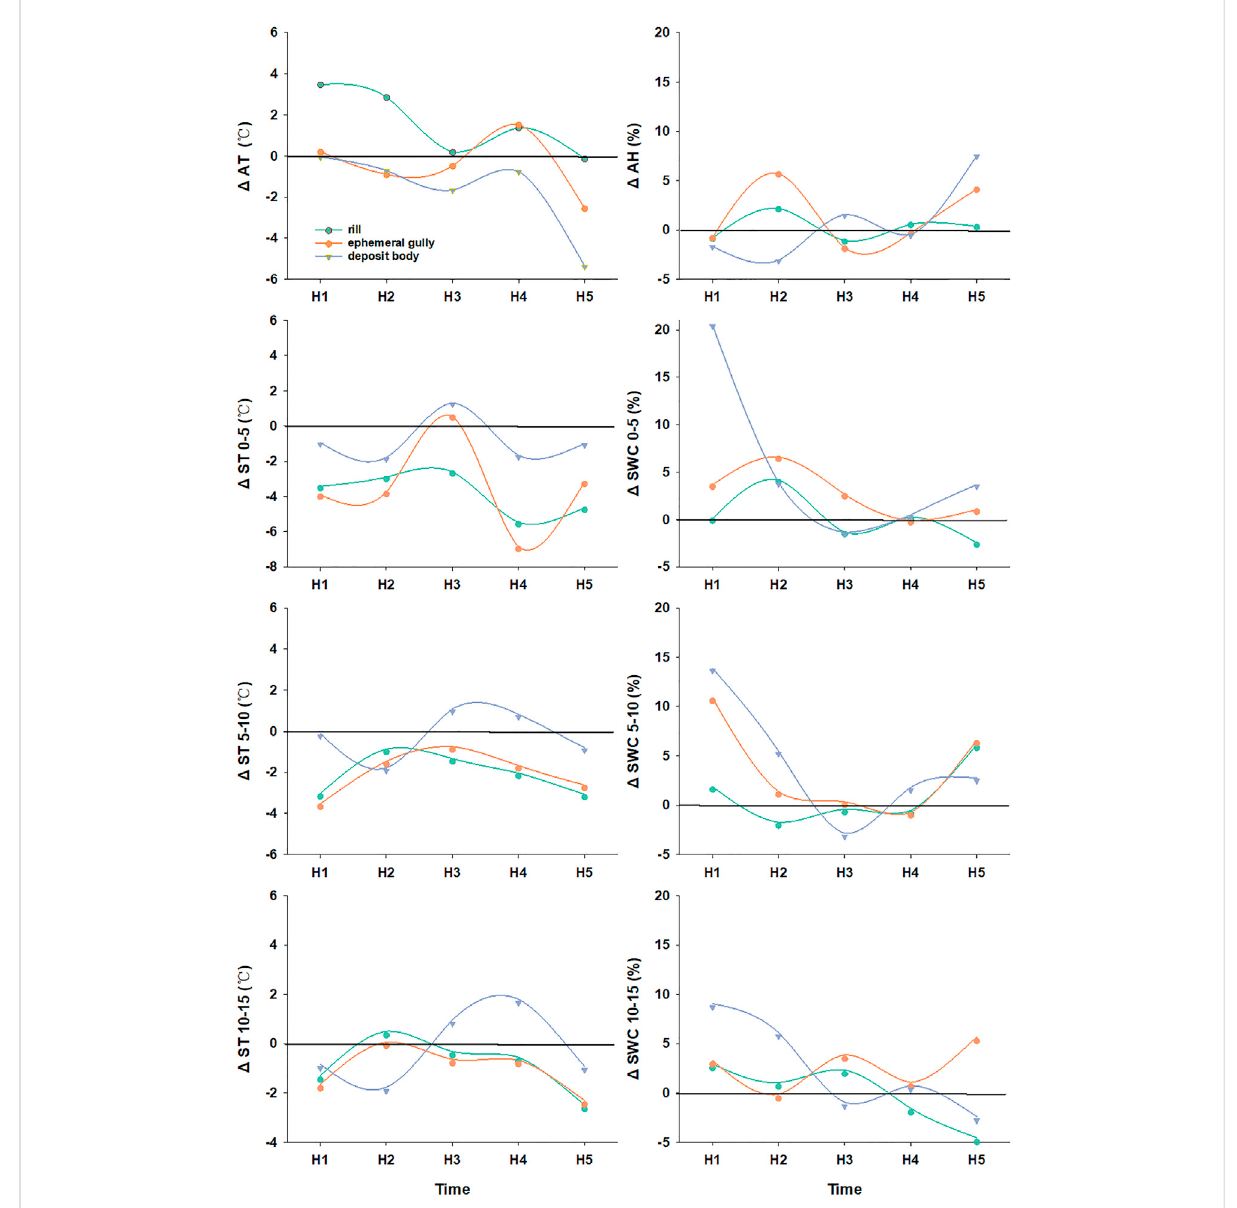
FIGURE 4 Temporal dynamics of micro-climates and hydrothermal conditions in the four micro-topographies. Δ AT for the D-value of air temperature near the substrate surface compared with the bare slope; Δ AH for the D-value of air humidity near the substrate surface compared with the bare slope; Δ ST 0 – 5 cm, Δ ST 5 – 10 cm, and Δ ST 10 – 15 cm for the D-value of a substrate temperature of 0 – 5 cm, 5 – 10 cm, and 10 – 15 cm layers, respectively, compared with the bare slope; Δ SWC 0 – 5 cm, Δ SWC 5 – 10 cm, and Δ SWC 10 – 15 cm for the D-value of the substrate water content of 0 – 5 cm, 5 – 10 cm, and 10 – 15 cm layers, respectively, compared with the bare